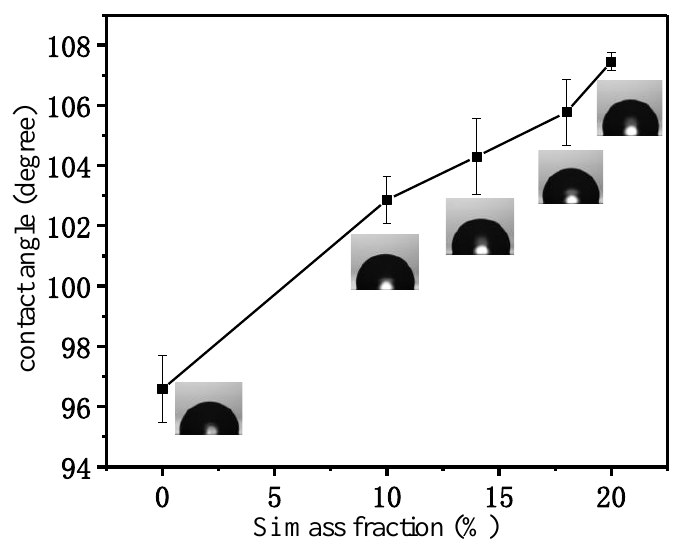
Figure 7. Water contact angle of the Si/PC copolymer with different Si mass fraction.